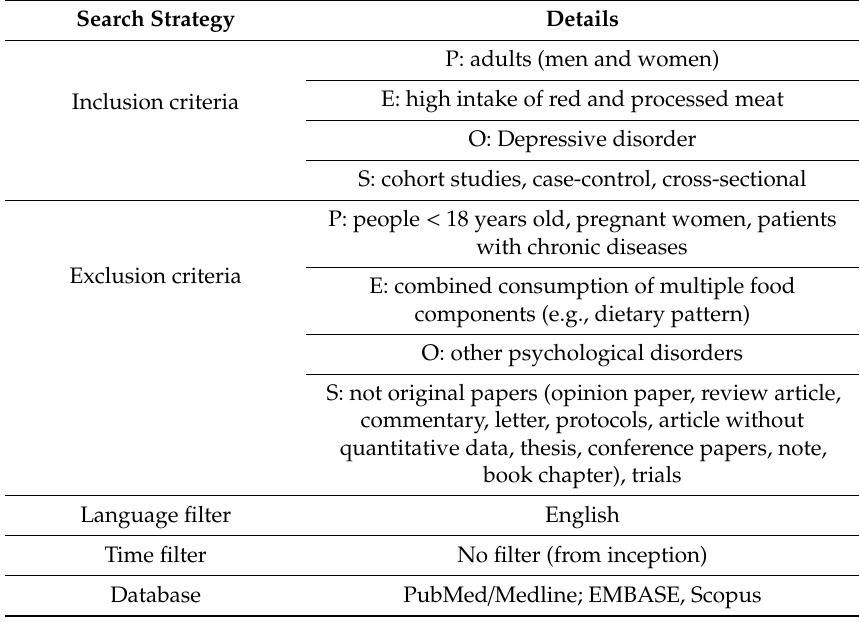
Table 1. Detailed description of inclusion / exclusion criteria according to a Population, Exposure, Outcomes and Study design